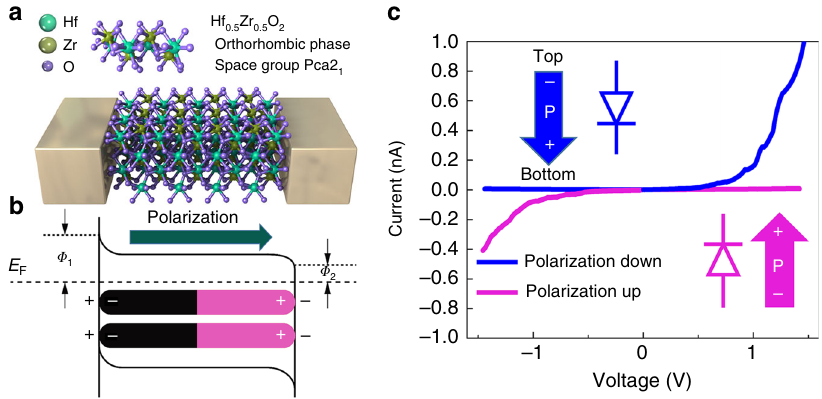
Fig. 3 Ferroelectric diode with a thin ( ∼ 10-nm) ferroelectric layer. a Schematic structure of the ferroelectric diode. b Schematics of the energy band diagrams of the Schottky-to-ohmic interfacial contacts in TiN/HZO/TiN modulated by polarization orientations. c Nonlinear diode-like I – V of the TiN/ HZO/TiN device with a cell size of 1 μ m. Insets represent a schematic of the potential energy pro fi les in two opposite